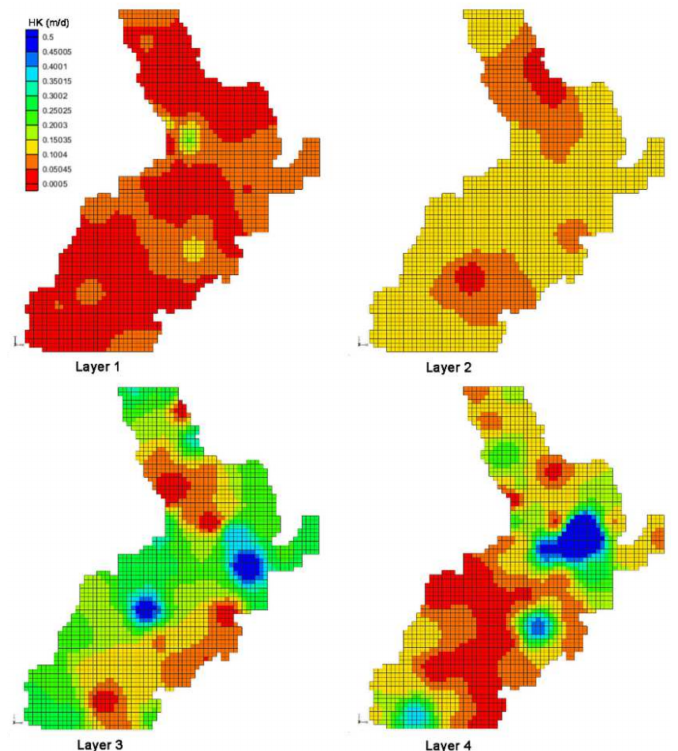
Figure 12. Spatial distribution of hydraulic conductivities after model calibration.